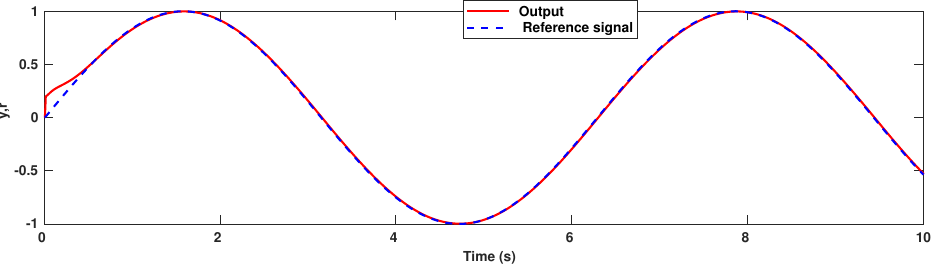
Figure 5. Example 1: the tracking performance.